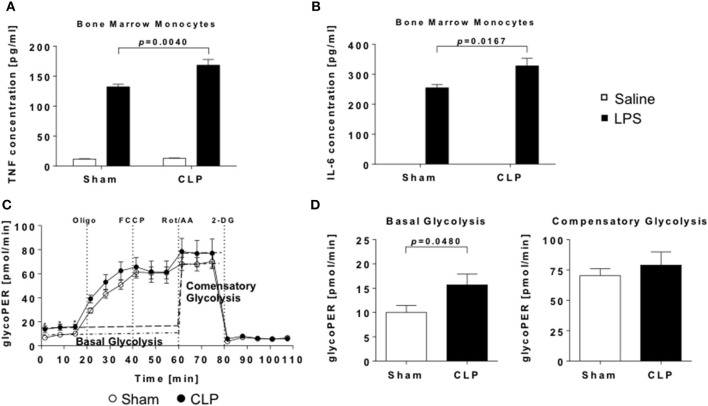
Enhanced inflammatory response to LPS and increased glycolytic activity of post-septic naïve bone-marrow monocytes. Monocytes were stimulated with LPS or saline for 24 h and levels of (A) TNF and (B) IL-6. in supernatants detected by ELISA. Metabolic activity of unstimulated monocytes was measured using Seahorse technology. (C) Cumulative glycolytic proton efflux rate and (D) evaluation of basal and compensatory glycolysis of bone marrow monocytes from CLP (black points/bars) or sham (open points/bars) mice. Data are represented as mean ± SEM, n = 9 per condition.